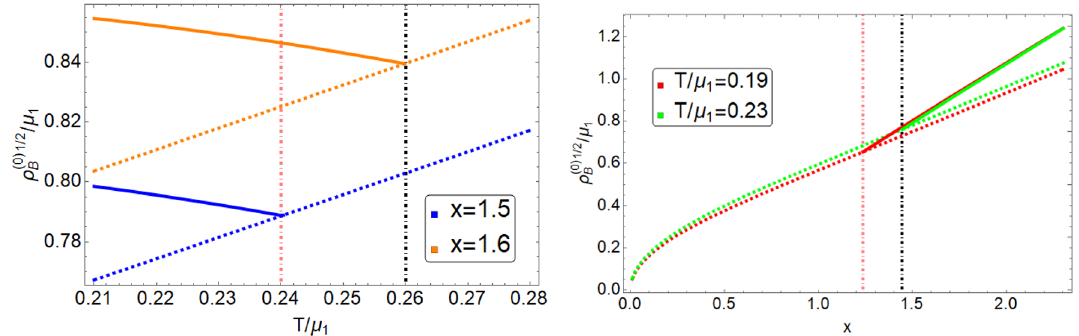
Figure 7 . The order parameter η (0) doping parameter x(right).